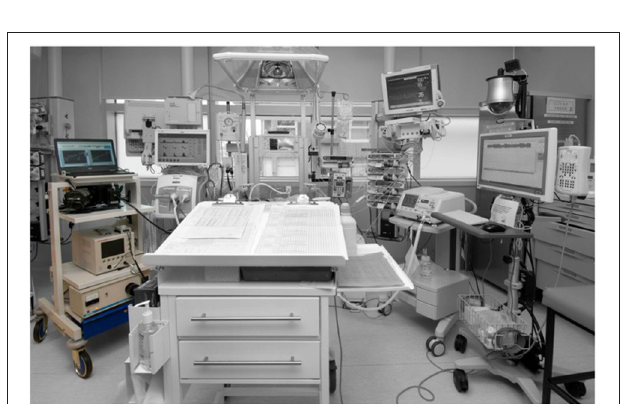
FIGURE 2 | Optimal continuous neuromonitoring in the NICU with video EEG (right), systemic monitoring (right back) and NIRS monitoring (left—a commercial oximeter is used here with a purpose built broadband NIRS